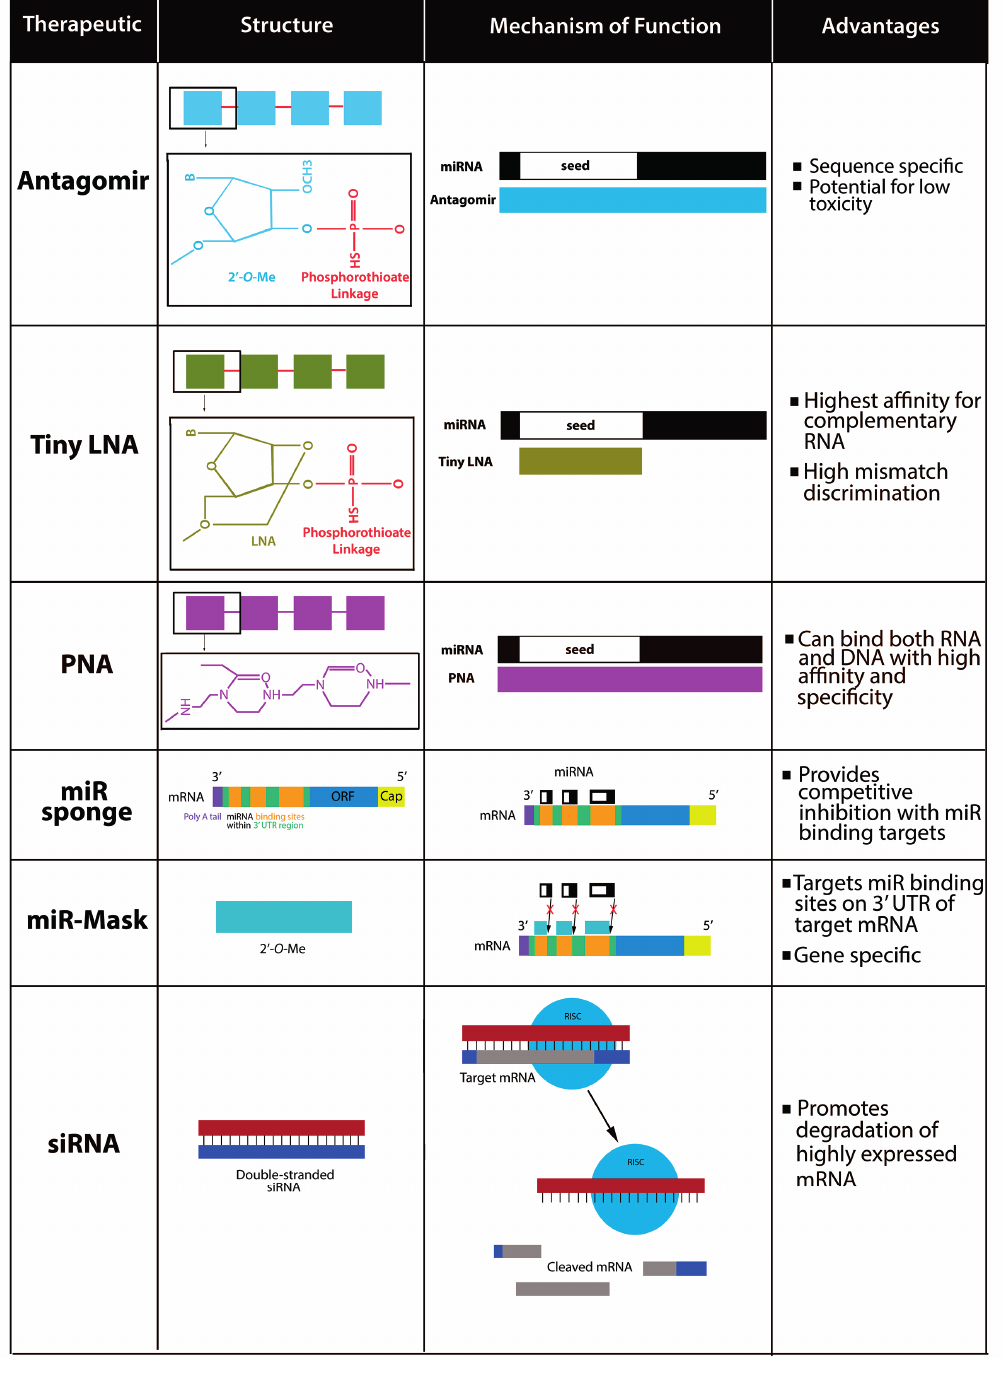
Figure 2. Structure, mechanism of function, and advantages of therapeutic strategies used to target miRNAs. For antagomirs, tiny LNAs, and PNAs, molecular structures of the first monomer and linkages are indicated within the black